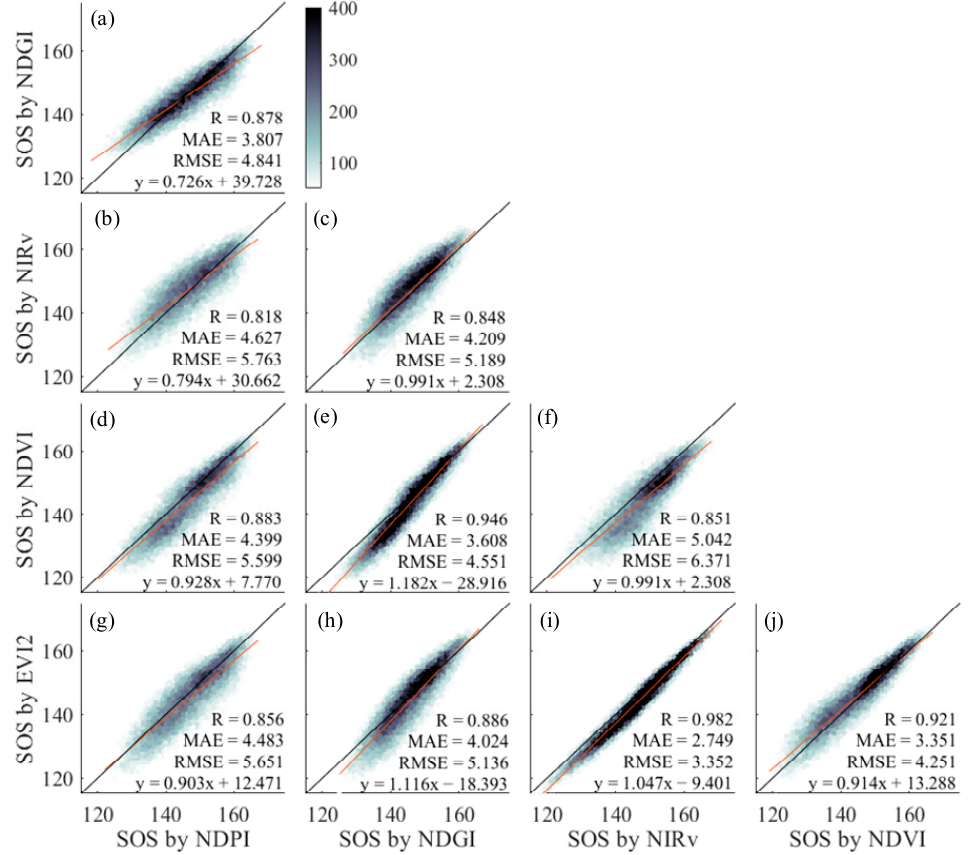
Figure 17. Comparison of the SOS detected by different VIs for SCDr < 20%. The color from light gray to dark gray indicates increasing sample densities. ( a – j ) are scatterplots of the SOS dates detected from different VIs on a pixel-by-pixel basis.